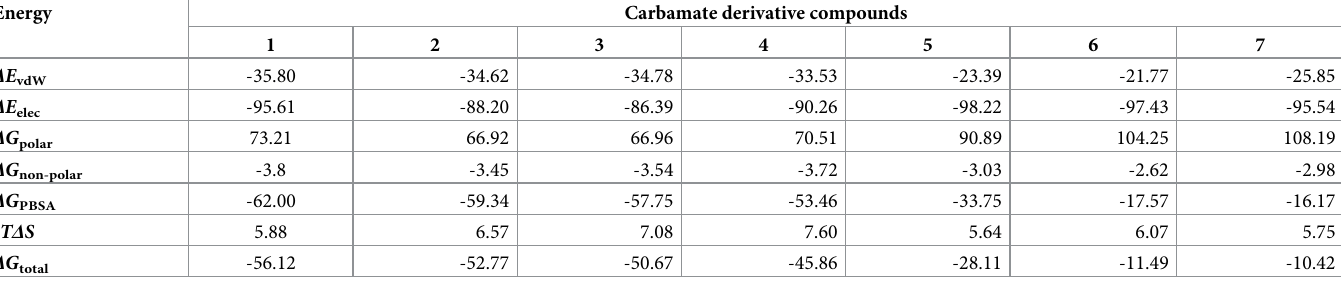
Table 2. Binding free energy of complexes between HDAC2 and seven carbamate derivative inhibitors based on 100-ns MD simulations and MM-PBSA calcula- tions. The entropic contributions were calculated using the quasi-harmonic (QH) approximation. All values are presented in kcal/mol.